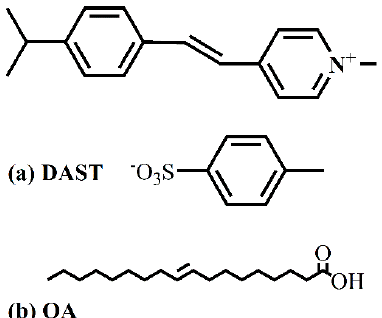
Figure 1. Molecular structures of ( a ) DAST and ( b ) OA, respectively.